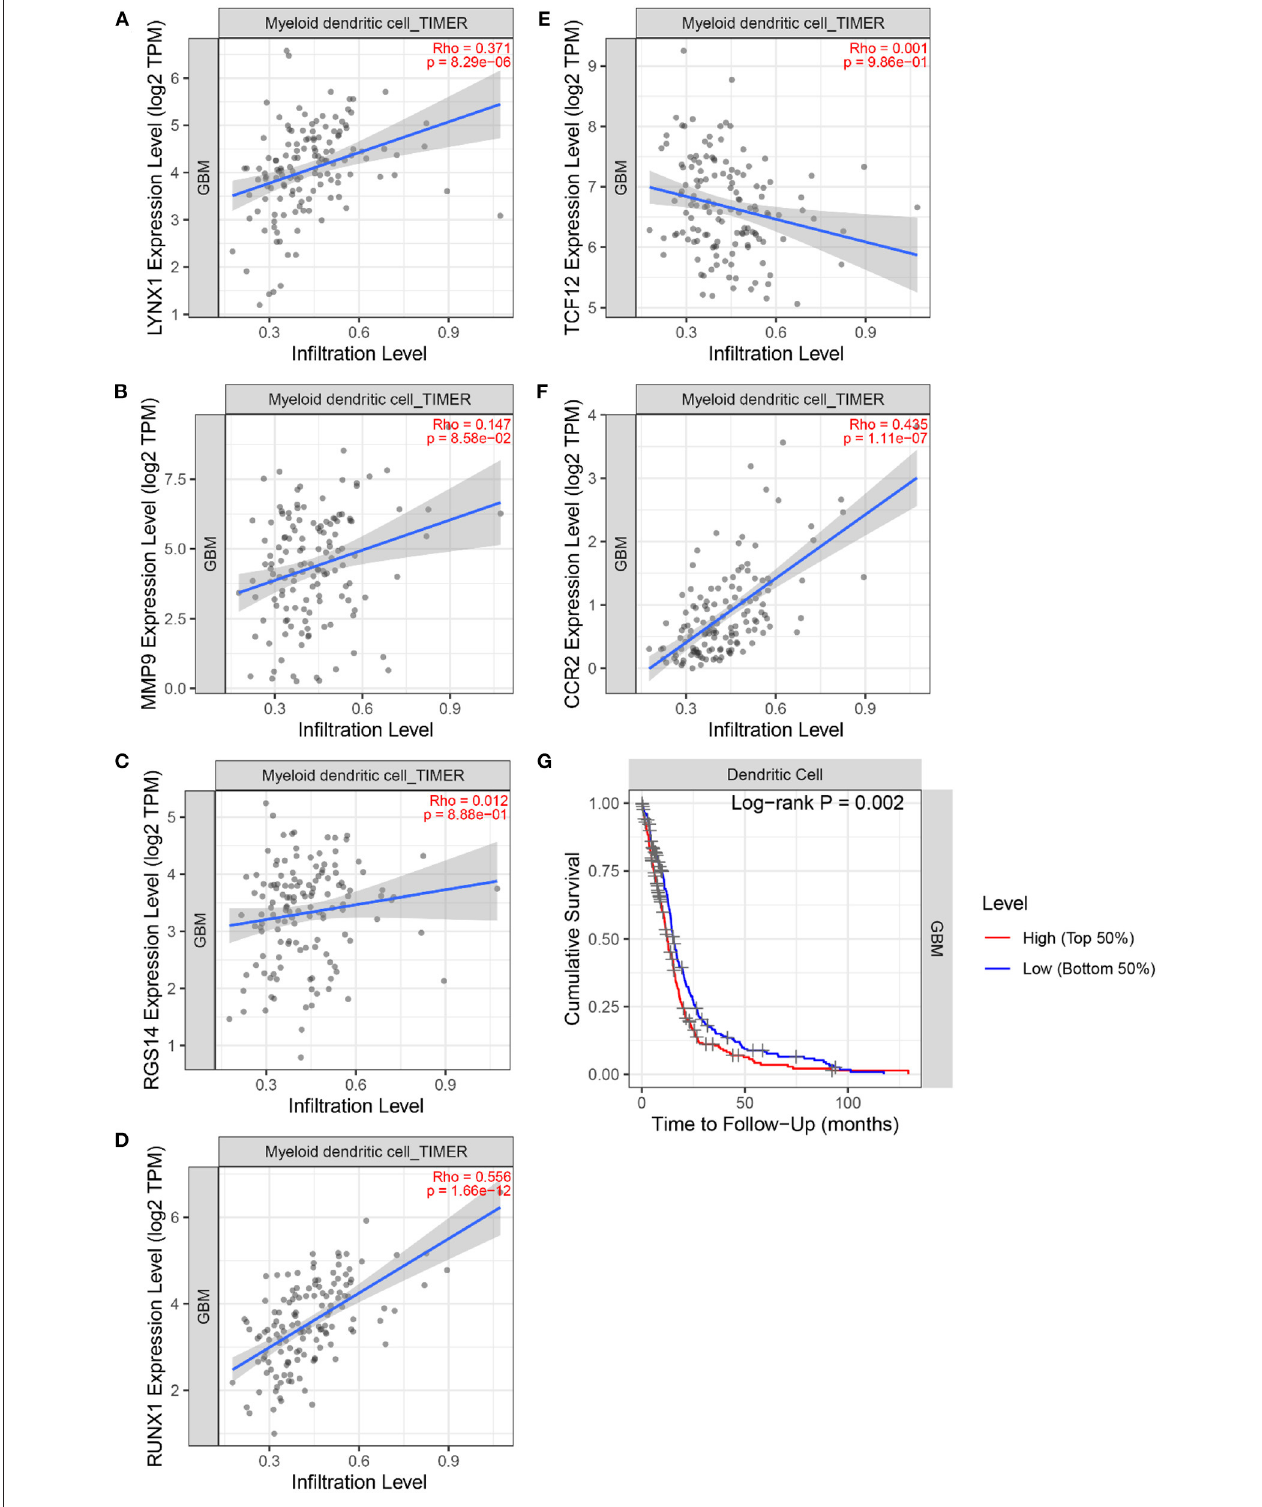
FIGURE 11 | The correlation between 6 marker genes and DC. (A) LYNX1. (B) MMP9. (C) TCF12. (D) RGS14. (E) RUNX1. (F) CCR2. (G) Kaplan–Meier analysis of the DC infiltrating levels from the TCGA database.